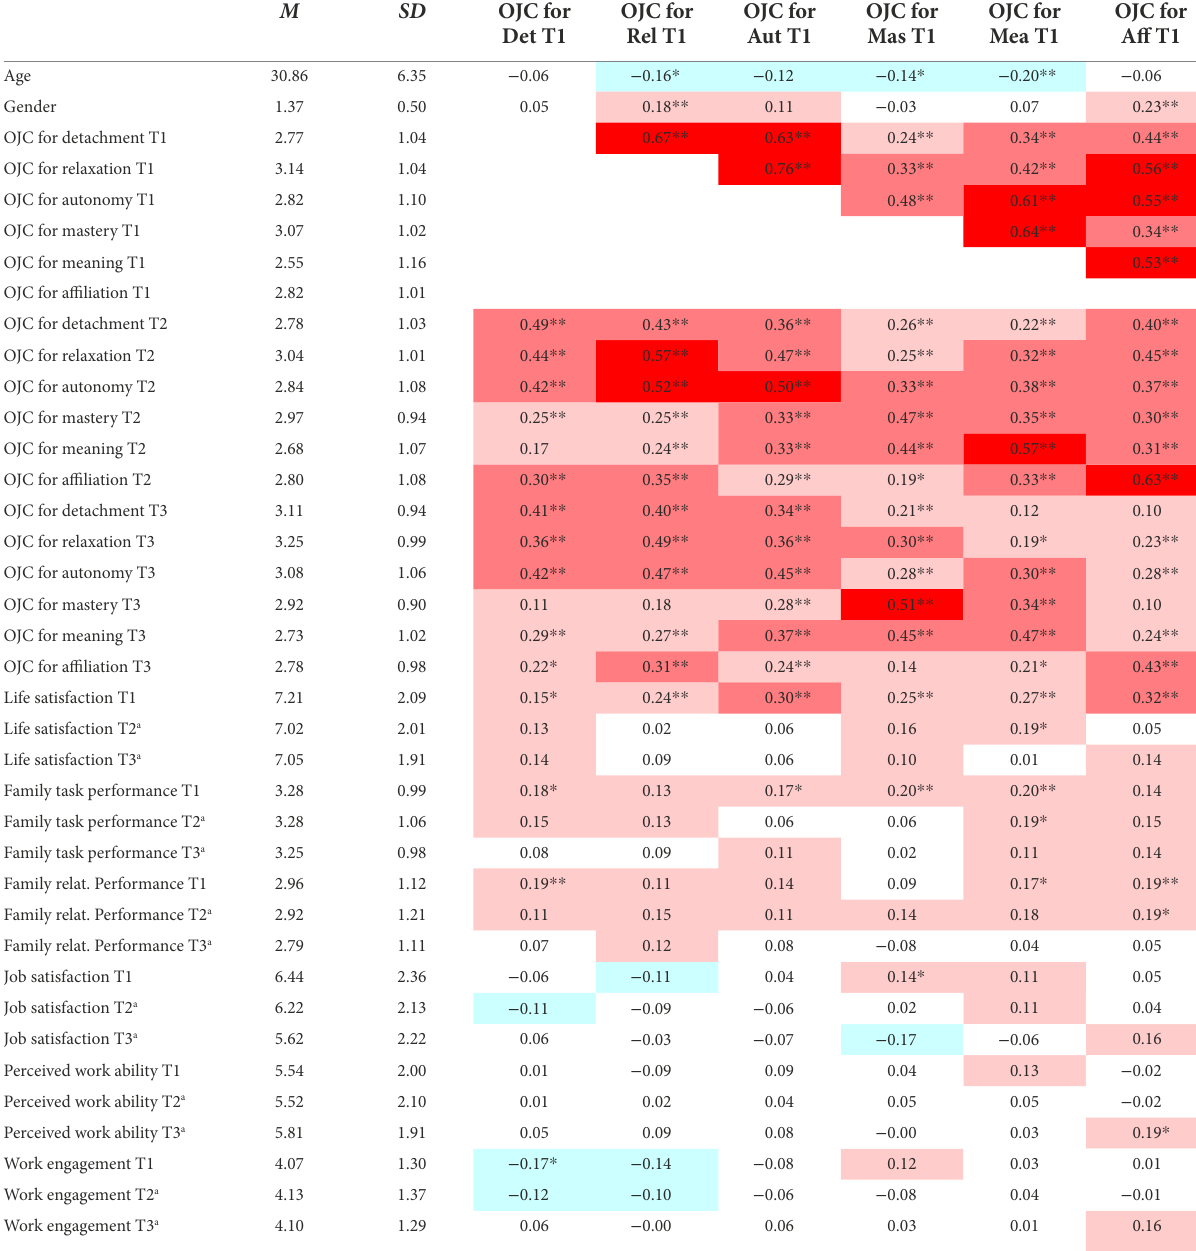
TABLE 7 Zero-order (cross-sectional and inter-scale) correlations and partial correlations of the OJC dimensions, Study 4.